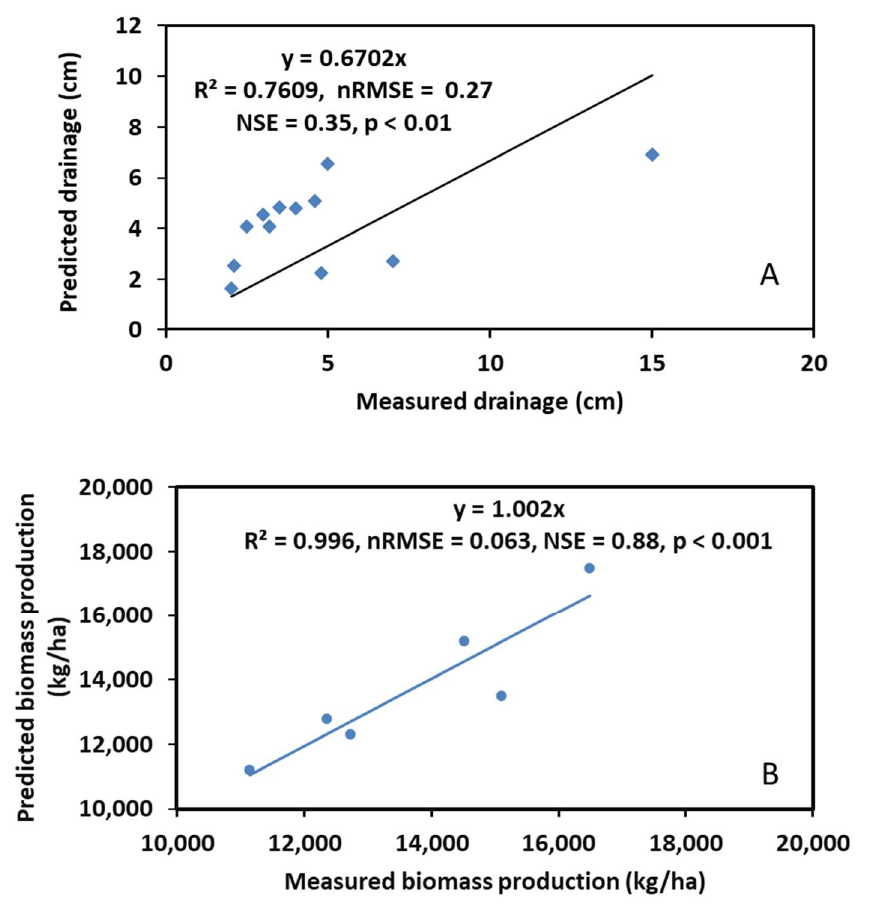
Figure 4. Comparison of model predicted and field measured soil water drainage ( A ) and biomass production ( B ) during model calibration.